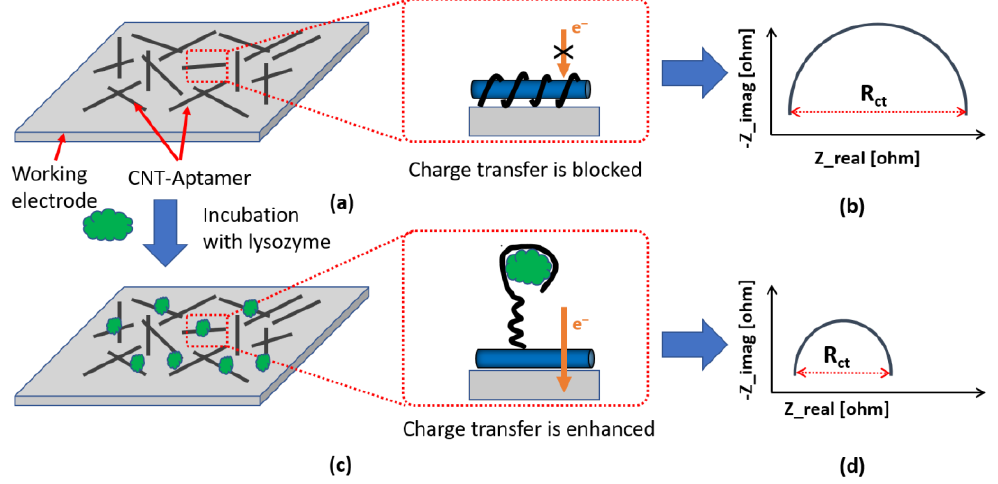
Figure 1. Working principle of the aptamer-based biosensor. Initially, the printed sensor blocks the charge transfer from the redox probe to the electrode due to the negative backbone of DNA bases ( a ); and the corresponding Nyquist curve ( b ). When exposed to the lysozyme, the anti-lysozyme aptamer unwraps itself from the carbon nanotube (CNT) and binds to the lysozyme, opening up the current path for enhanced charge transfer ( c ); and the corresponding Nyquist curve ( d ).